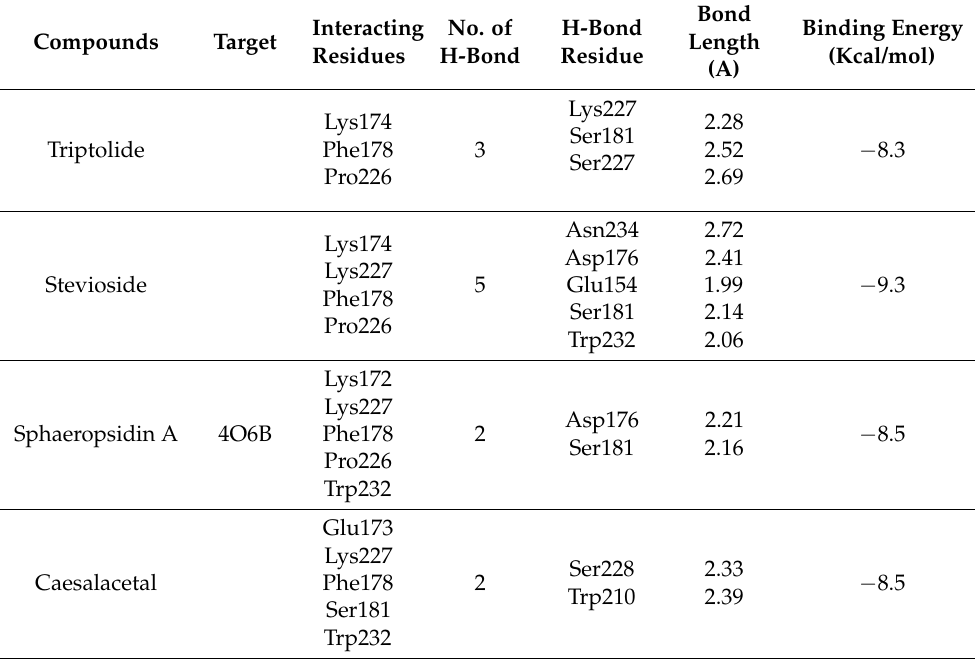
Table 5. The four best results for the docking of natural bioactive ligands with viral proteins target